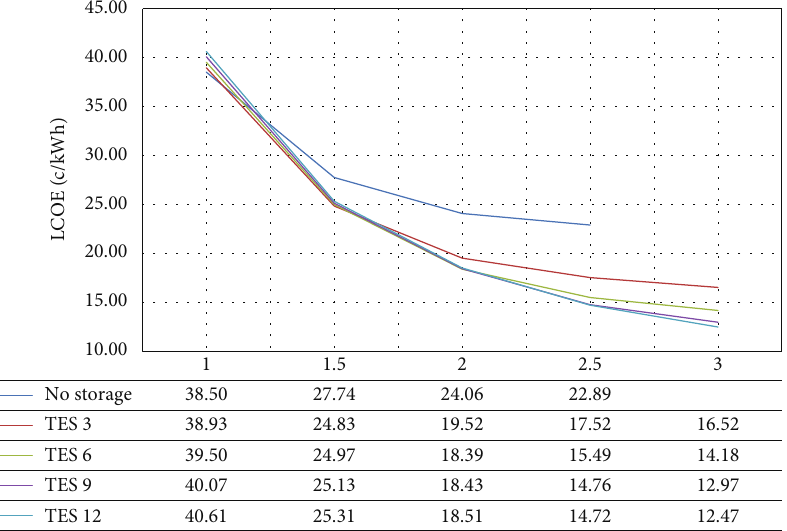
Figure 10: LCOE for di ff erent SM and hours of